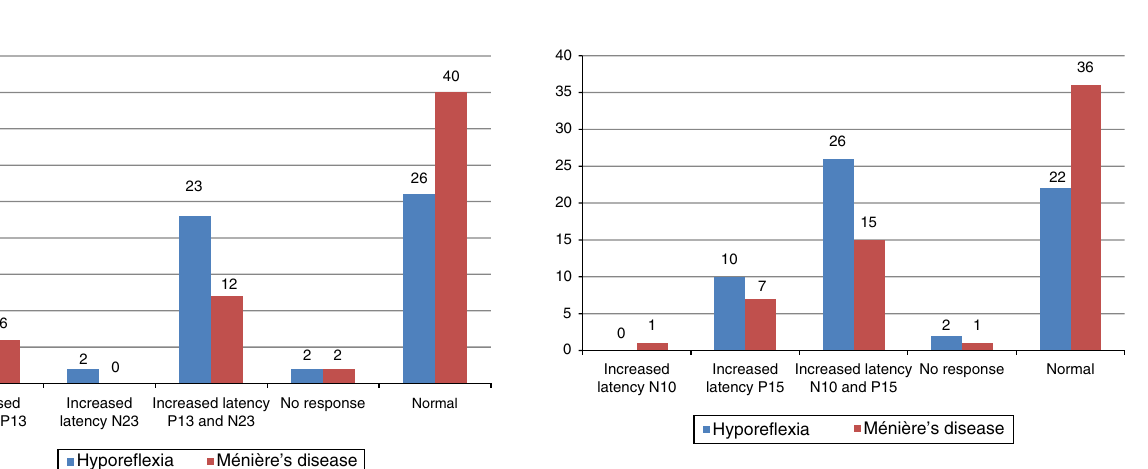
Figure 3 Frequency distribution of the results of ocular VEMP, per ear, for individuals with vestibular hyporeflexia and for indi- viduals with Ménière’s disease ( n =